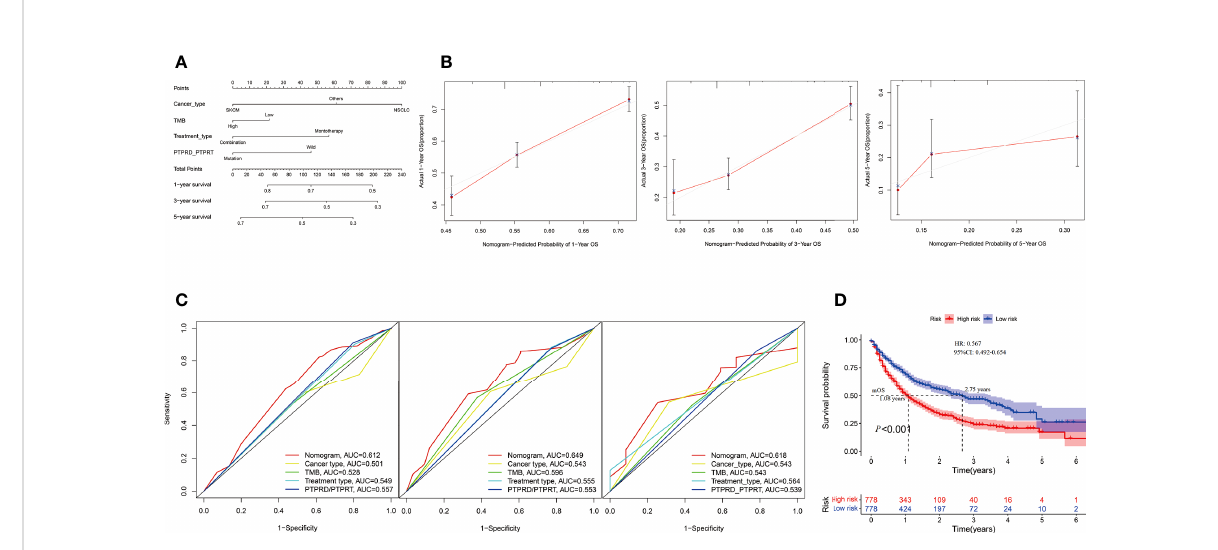
FIGURE 9 Construction of an integrated prognostic nomogram model. (A) Nomogram based on cancer type, TMB, treatment type and PTPRD/PTPRT mutation status of the Samstein cohort. (B) Calibration plot of the nomogram for the probability of OS at 1- (left),3- (middle) and 5- (right) years in the Samstein cohort. (C) Receiver operating characteristic (ROC) curves for predicting OS at 1- (left),3- (middle) and 5- (right) years in the Samstein cohort. (D) Survival curve of OS with the nomogram in the Samstein